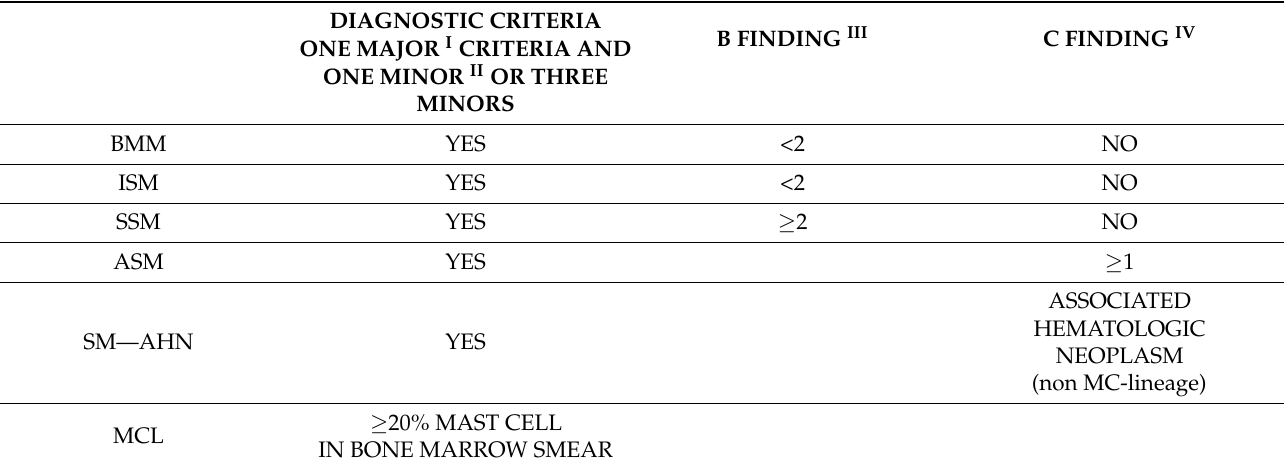
Table 1. World Health Organization (WHO) classification of Systemic Mastocytosis. DIAGNOSTIC CRITERIA B FINDING III C FINDING IV ONE MAJOR I CRITERIA